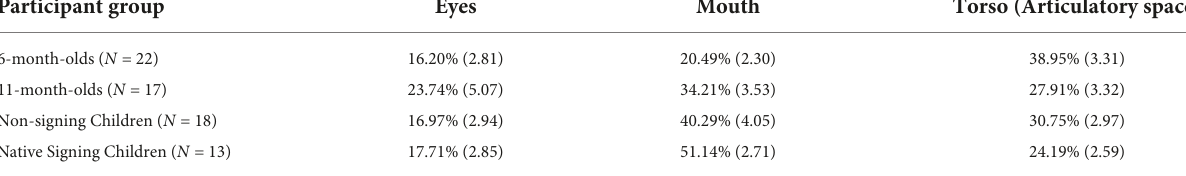
TABLE 4 Mean percentage looking values for each group, collapsed across body action type. Participant